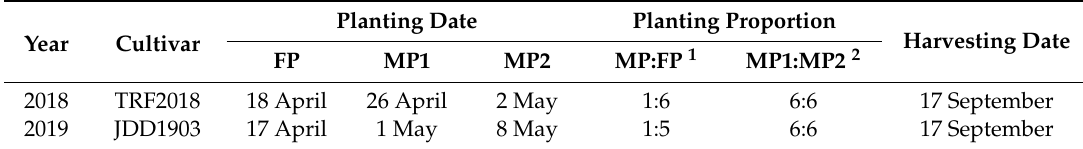
Table 1. Cultivars, planting dates of female parents (FP) and first (MP1) and second (MP2) batches of male parents, planting proportions, and harvest date of hybrid maize seeds in each